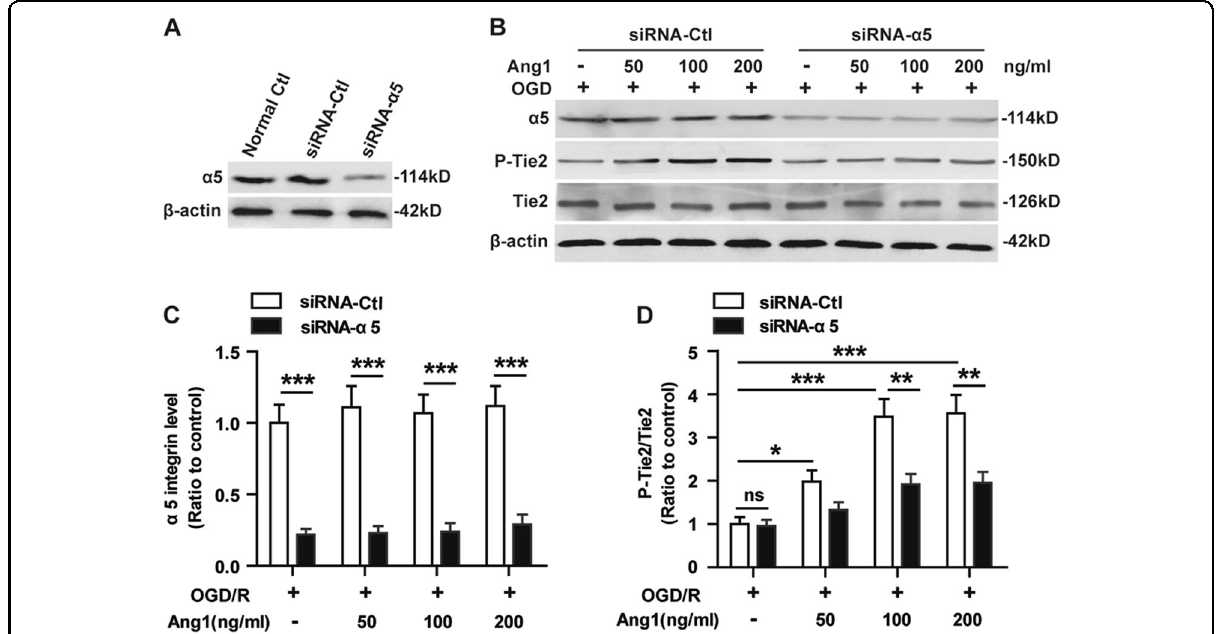
Fig. 4 Integrin α 5 β 1 acts to enhance Ang1-activated Tie2 signaling after OGD. a BECs were transfected with negative control siRNA (siRNA-Ctl) or α 5 integrin-speci fi c siRNA (siRNA- α 5) for 48 h. Levels of α 5 β 1 protein were monitored in the control and silenced cells via western blotting. b – d BECs were transfected with siRNA-Ctl or siRNA- α 5 for 48 h, then subjected to 4 h of OGD, and further stimulated or not with Ang1 (50, 100, or 200 ng/mL) for 15 min under normoxia at 37 °C. b The protein levels from OGD-treated BEC lysates were analyzed by western blotting using antibodies speci fi c to integrin α 5 and total or phosphorylated forms of Tie2. c – d Densitometric analysis shows the relative amount of integrin α 5 ( c ) and phosphorylated Tie2/total Tie2 ( d ). The OGD/R siRNA-Ctl-treated cells served as the control. Data represent the mean ± SEM and were analyzed by two-way ANOVA (n = 5). Note that integrin α 5 knockdown in BECs signi fi cantly decreased α 5 β 1 protein expression after OGD. Knockdown of integrin α 5 in BECs did not signi fi cantly decrease the levels of Tie2 phosphorylation after OGD. Ang1 signi fi cantly increased the levels of Tie2 phosphorylation in a dose-dependent manner on siRNA-Ctl-treated BECs after OGD, but this effect was signi fi cantly reduced by integrin α 5 knockdown. * P < 0.05, *** P < 0.001, ns, not signi fi